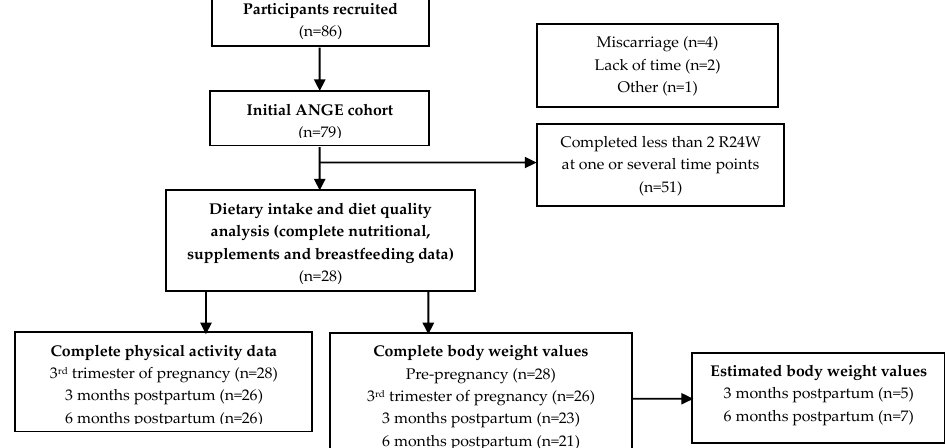
Figure 1. Flowchart of the study sample.